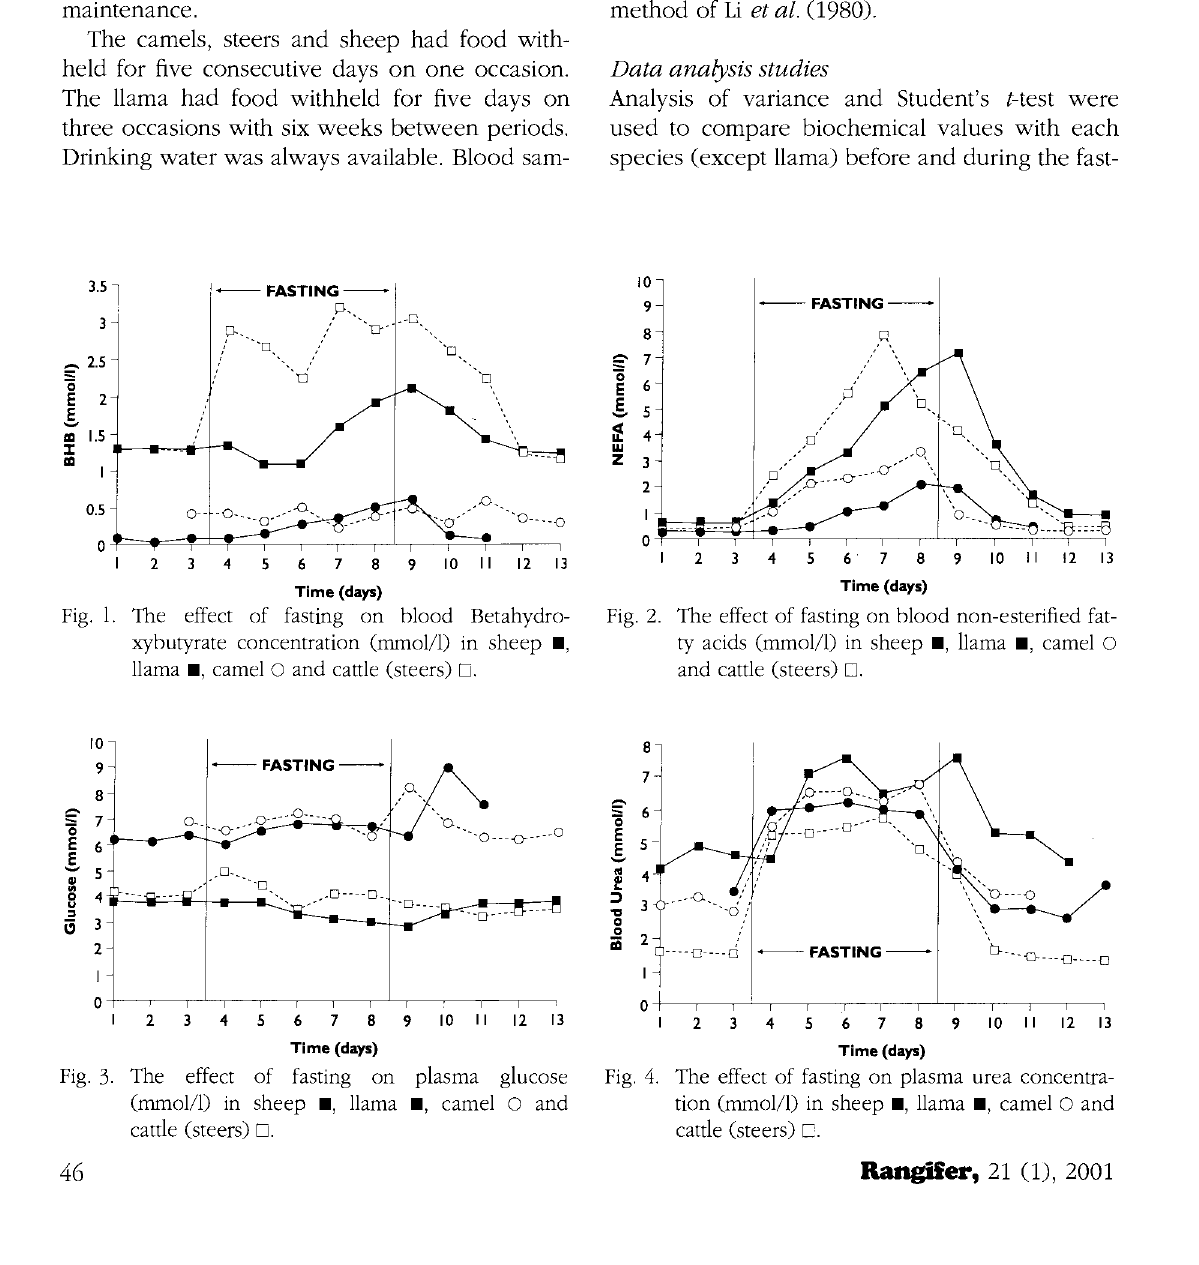
Fig. 4. The effect of fasting on plasma urea concentra tion (mmol/1) in sheep •, llama •, camel O and cattle (steers)